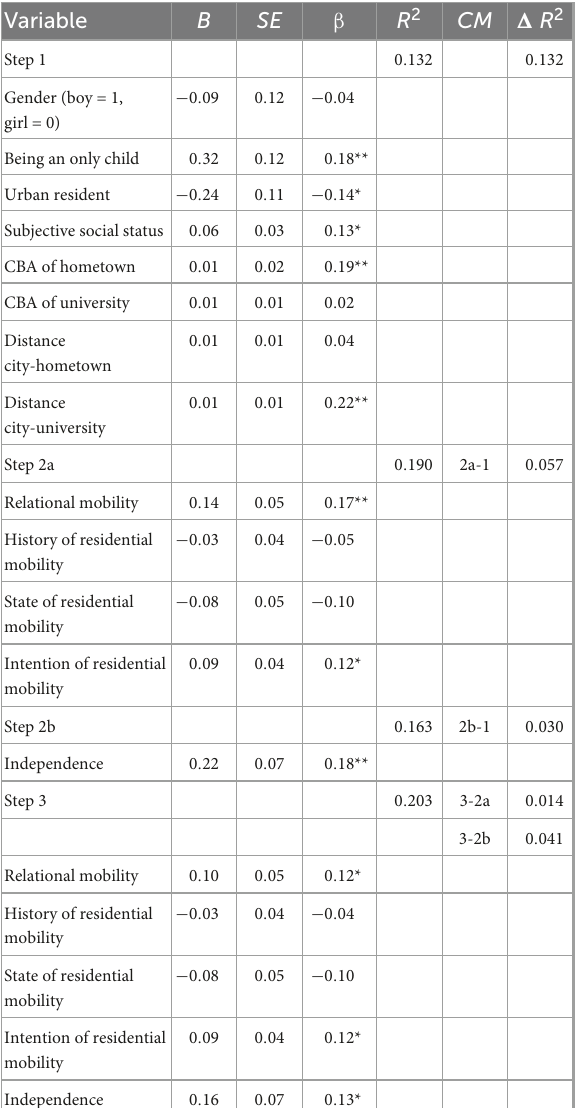
TABLE 3 Results of hierarchical regression analyses for dependence, mobility, and other covariates predicting preference for cosmopolitan cities (second preferred